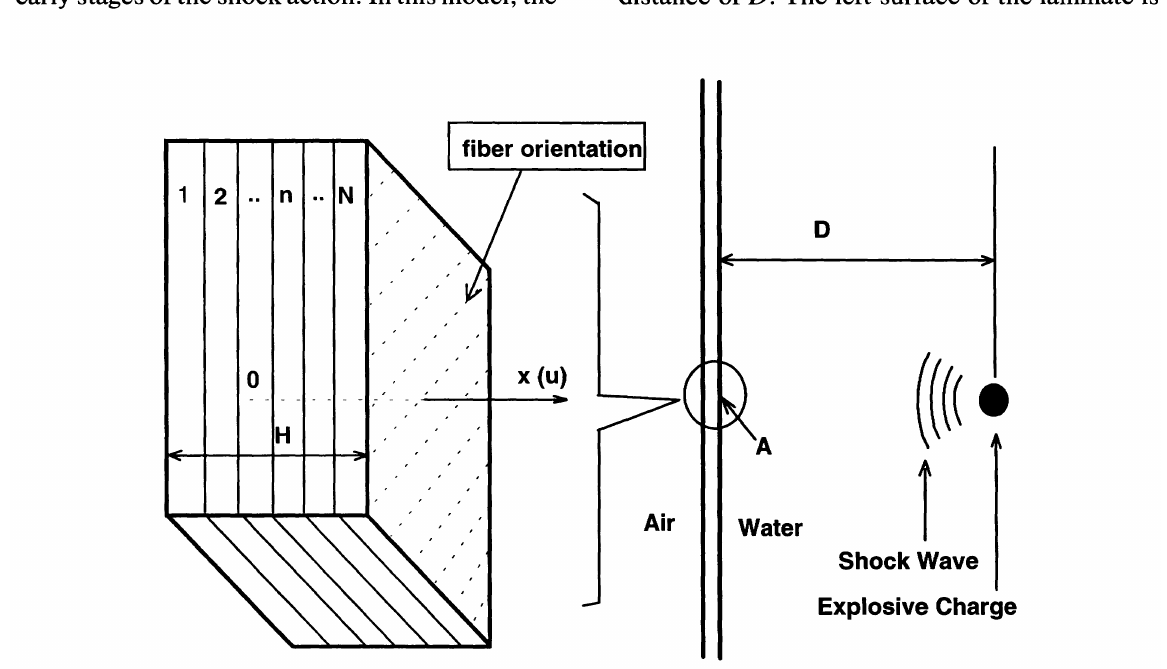
FIGURE 1 An isotropic laminate subjected to an underwater